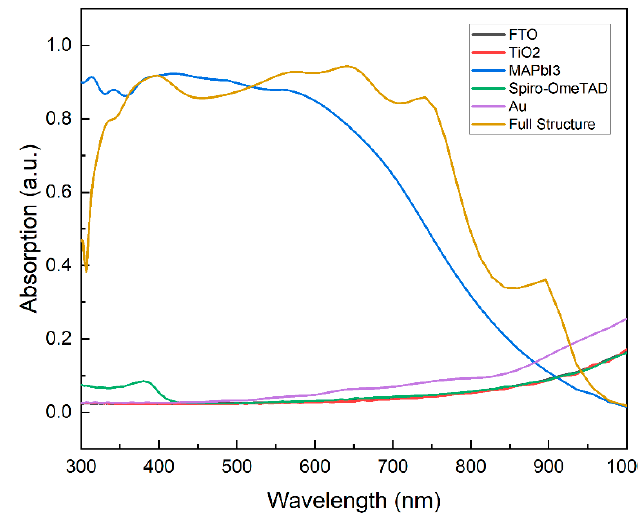
Figure 2. The absorption spectra for every layer in this structure.